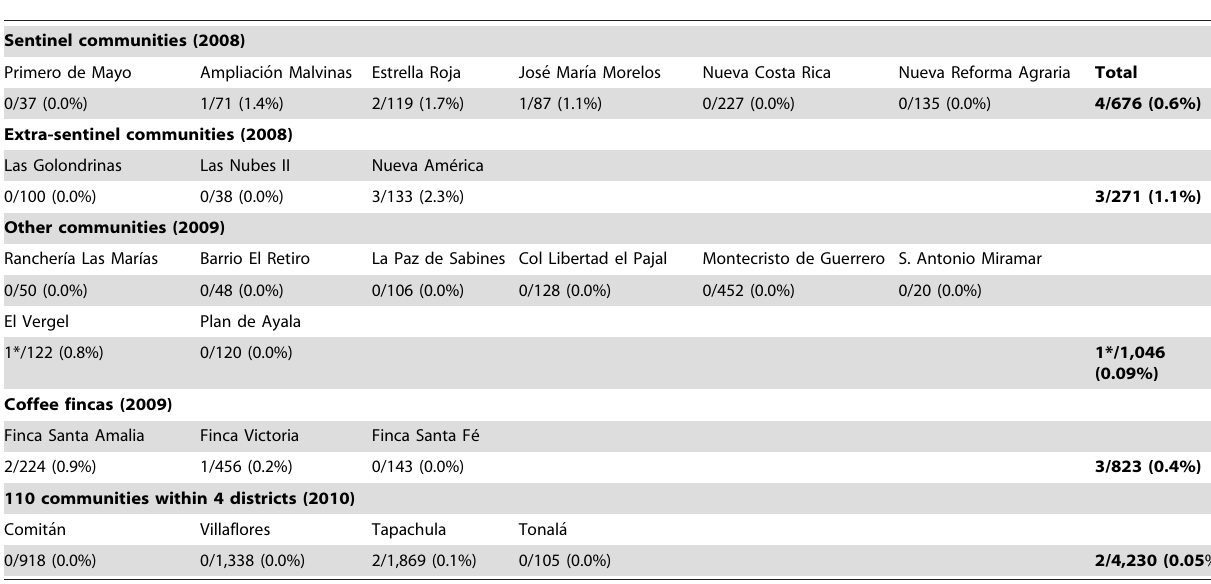
Table 3. Prevalence of IgG4 antibodies to Ov16 in the focus of Southern Chiapas, Me´xico.